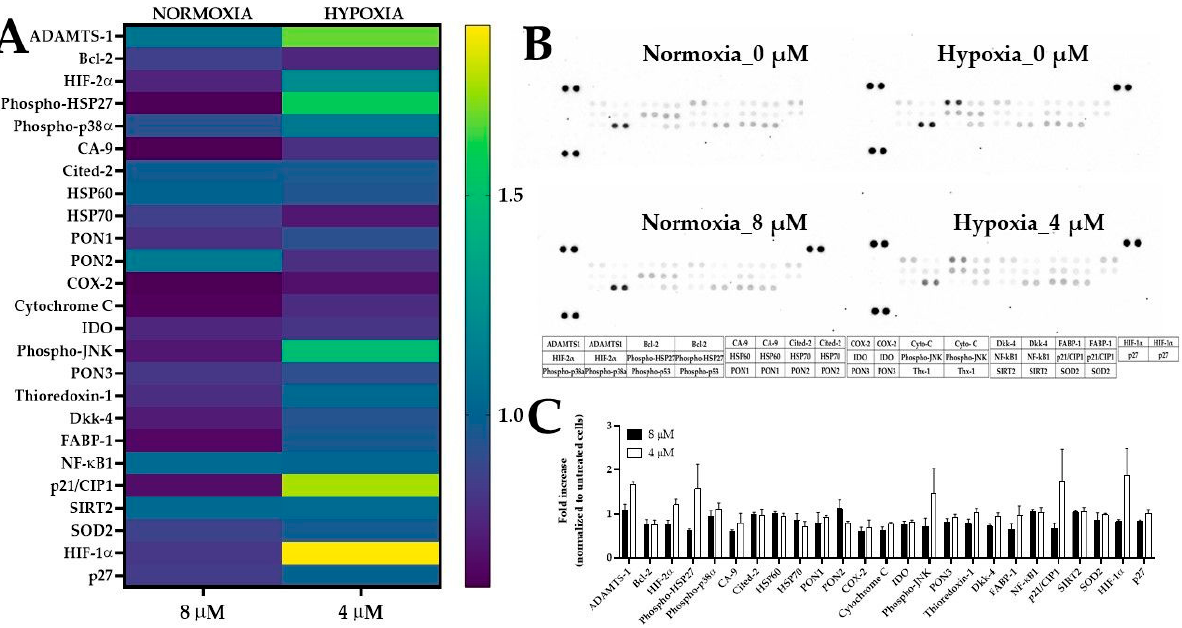
Figure 14. The effect of compound 5 on stress-related protein expression in 5637 cells under normoxic and hypoxic conditions. Panel ( A ) presents the expression of the proteins present as a heat map. Panel ( B ) shows the representative membrane images. Panel ( C ) presents the densitometric analysis expressed as the fold change in protein expression (relative to control means 1, a value greater than 1 means upregulation, and values less than 1 mean downregulation). Cells were treated with compound 5 at a concentration of 4 µM and 8 µM for 18 h. The densitometric analysis was performed using Image Studio Lite software. These data presented the mean values from two independent experiments. Chemiluminescent signals were detected by a charge-coupled device (CCD) camera-based digital imaging instrument (Thermofisher Scientific). Abbreviations: Bcl-2, B-cell lymphoma 2 protein; CA-9, carbonic anhydrase IX; Cited-2, Cbp/p300-interacting transactivator 2 protein;